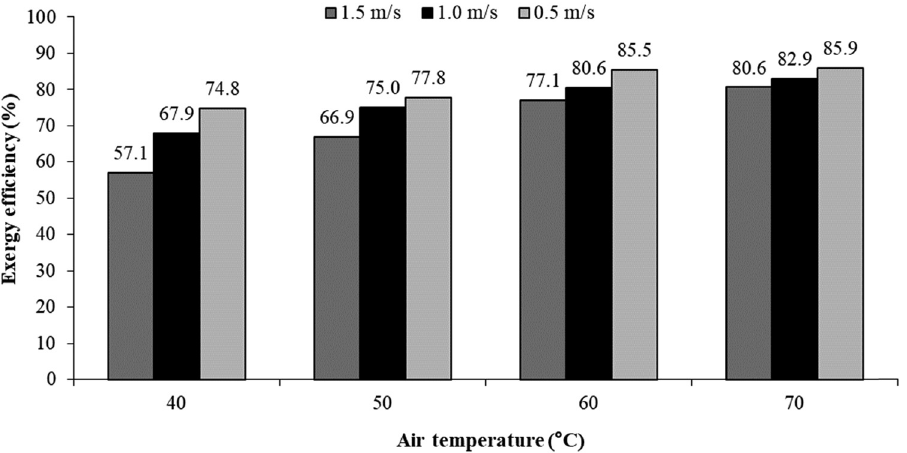
Figure 4: In fl uence of air temperature and velocity on the exergy e ffi ciency for the drying of potato slices.